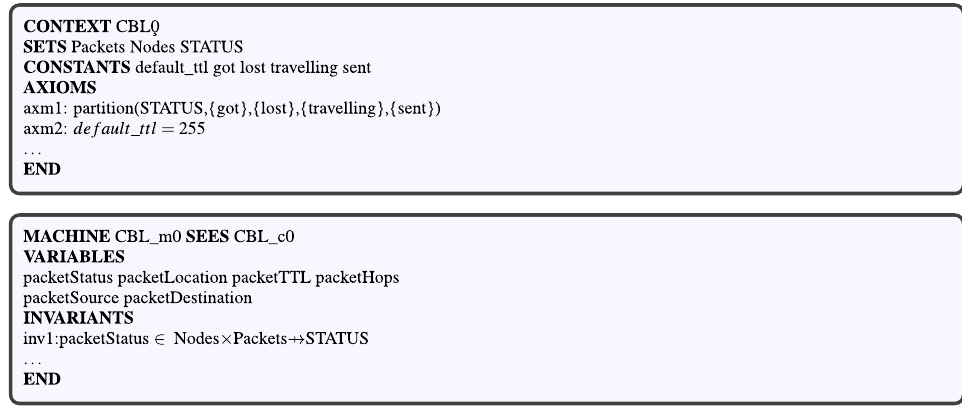
Figure 4. Level 1: nasic protocol model including a machine and a context.